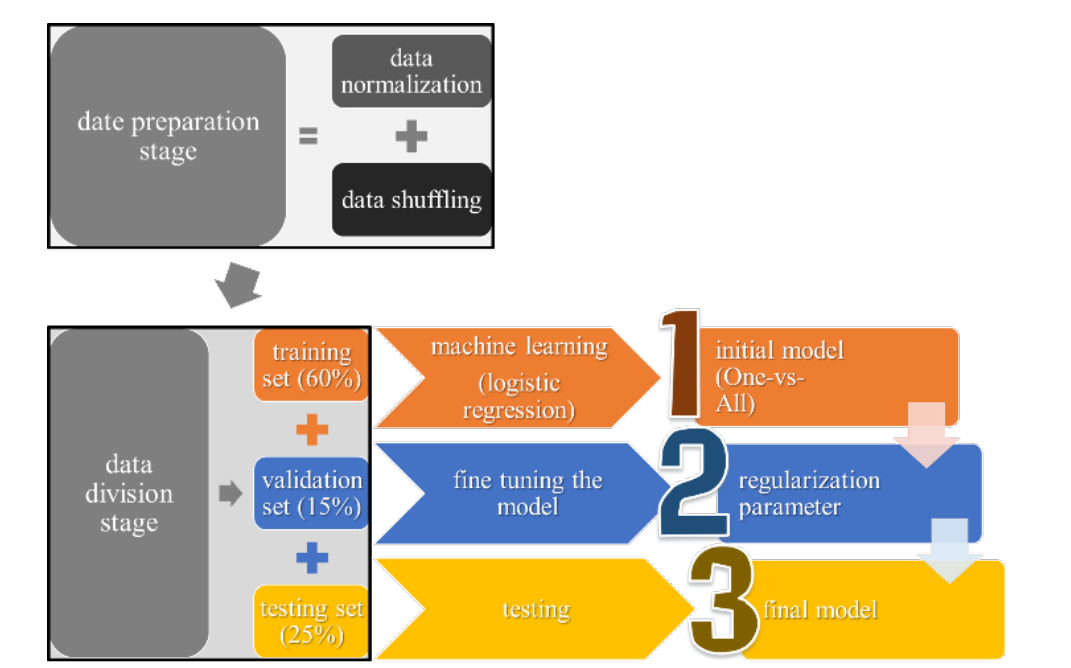
Table 6. Dataset samples per each fault type for training and testing sets.